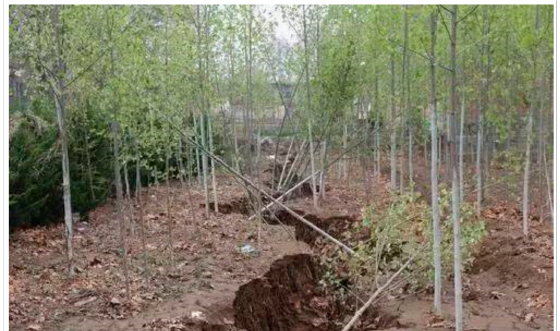
Figure 1. Cracked ground due to lightning strikes in Yuncheng, Shanxi, China.